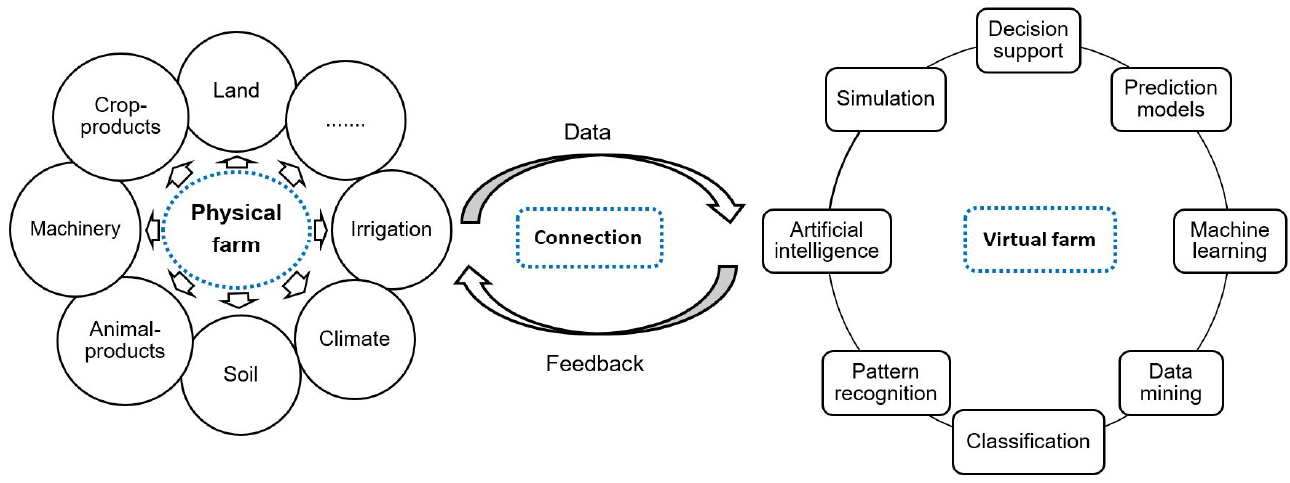
Figure 1. Schematic of digital twin concept for agriculture.